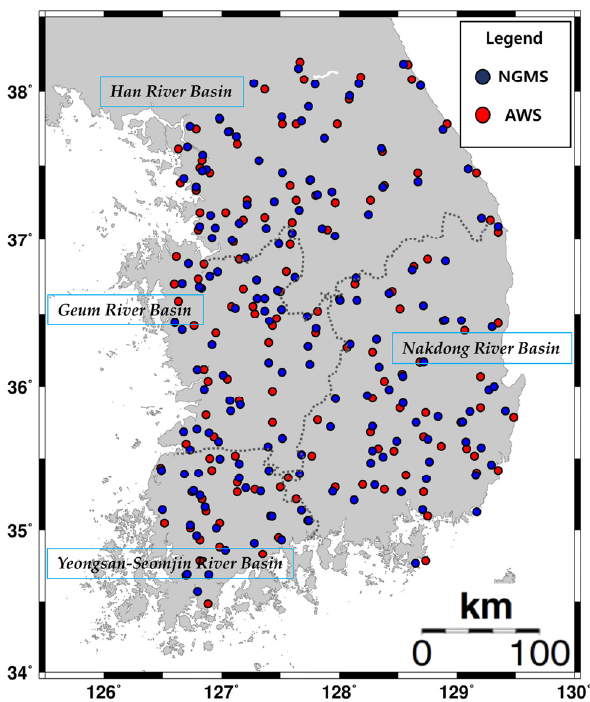
Figure 2. Locations of the 159 well pairs among the National Groundwater Monitoring Stations (NGMS) and adjacent automatic weather stations (AWS) in the Korean Peninsula.